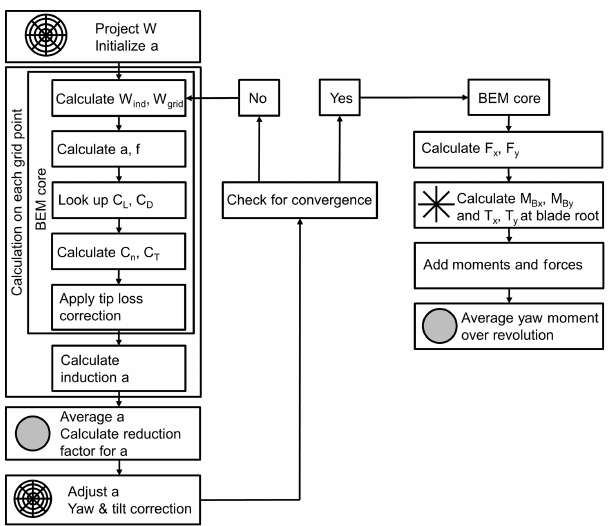
Figure 5. Flow chart for the implemented BEM code to compute the equilibrium yaw